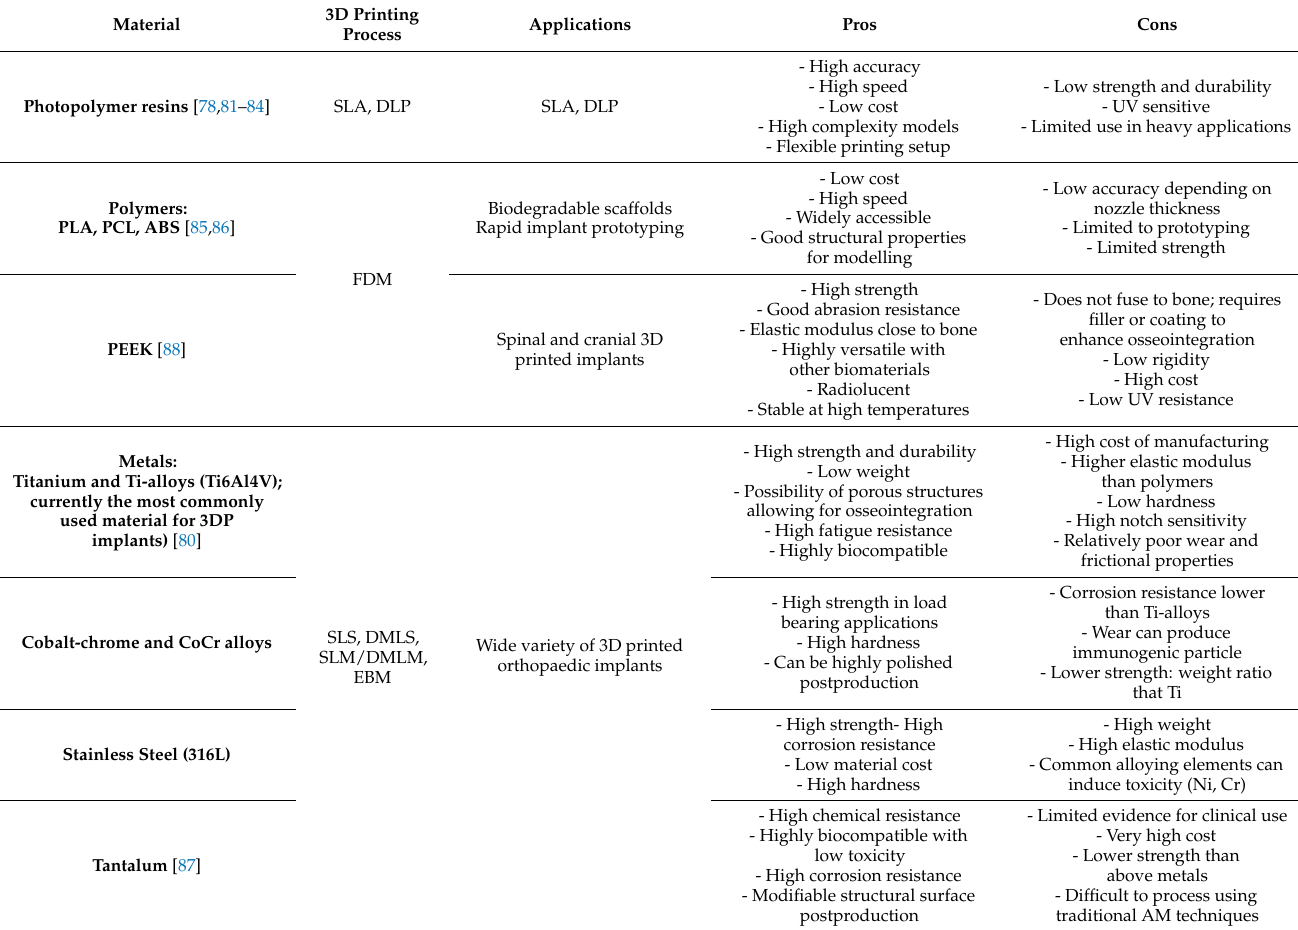
The main materials used for 3D printed modelling and implants. AM = Additive